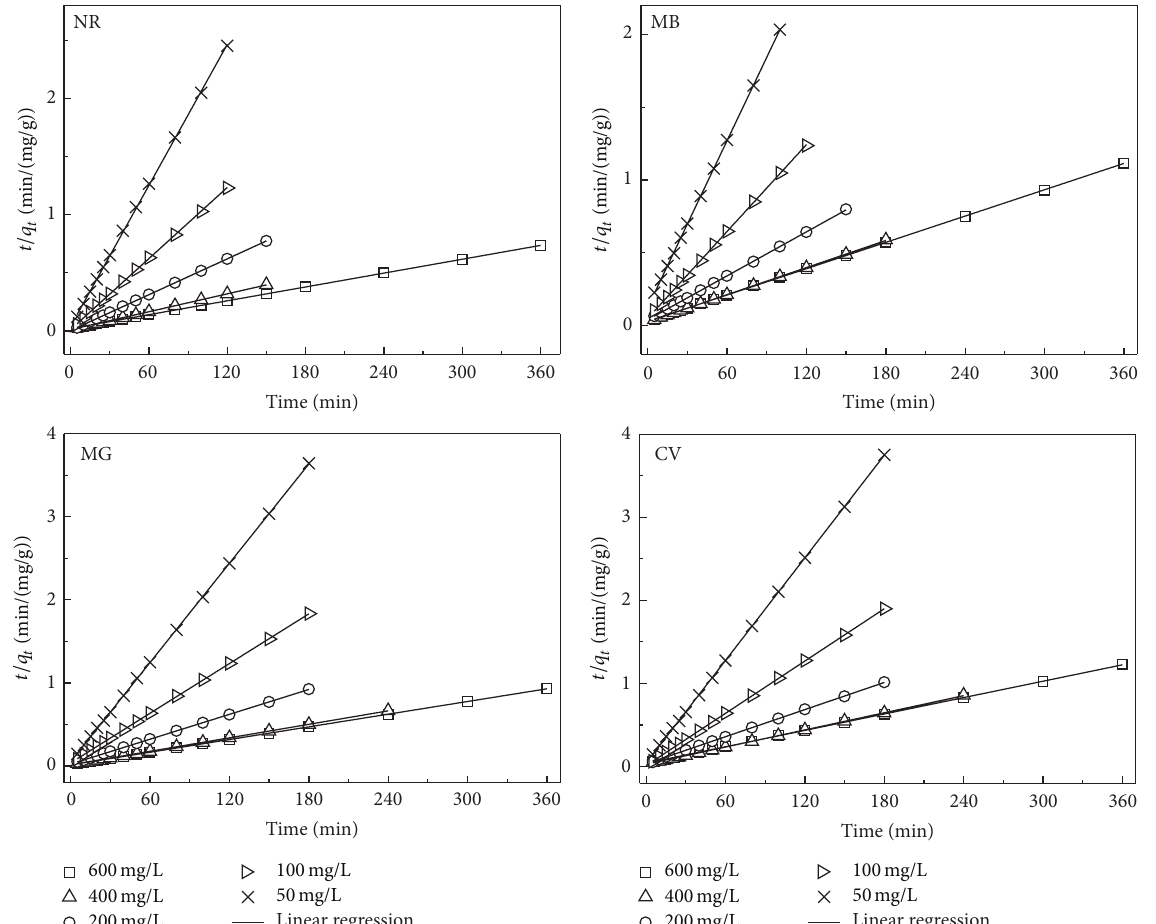
Figure 10: Pseudo-second-order kinetic plots for NR, MB, MG, and